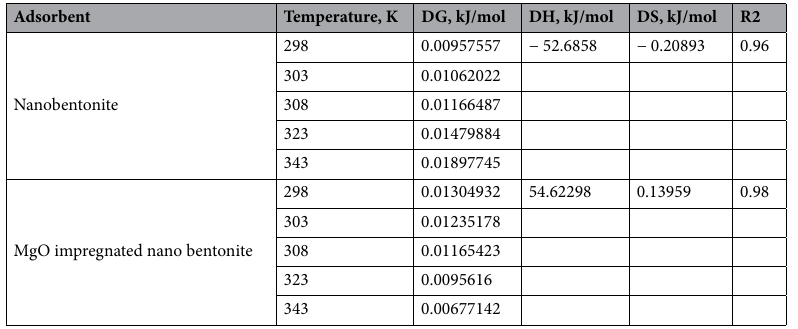
Table 6. Thermodynamic parameters of MG adsorption activity of nano bentonite and MgO impregnated